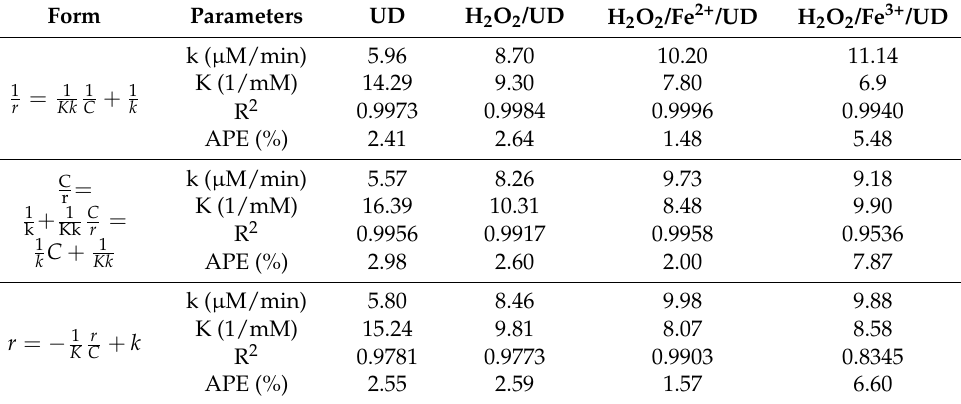
Table 2. Parameters for the model after Okitsu et al. obtained using the linear regression method. Form Parameters UD Form